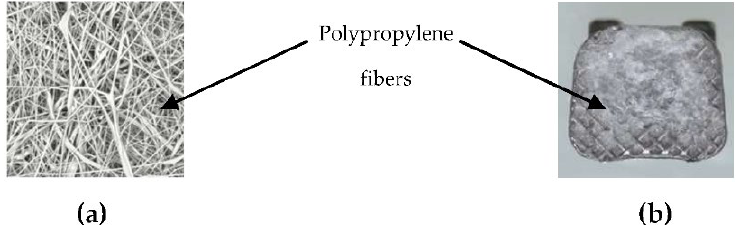
Figure 1. ( a ) The nonwoven polypropylene fibers used in the APC TM Flash-Free adhesive consists of randomly oriented, entangled fibers (3M TM APC TM Flash-Free Adhesive, Technical Overview); ( b ) The image from the light microscope digital camera with × 10 magnification (EP50 Olympus, Tokyo, Japan).